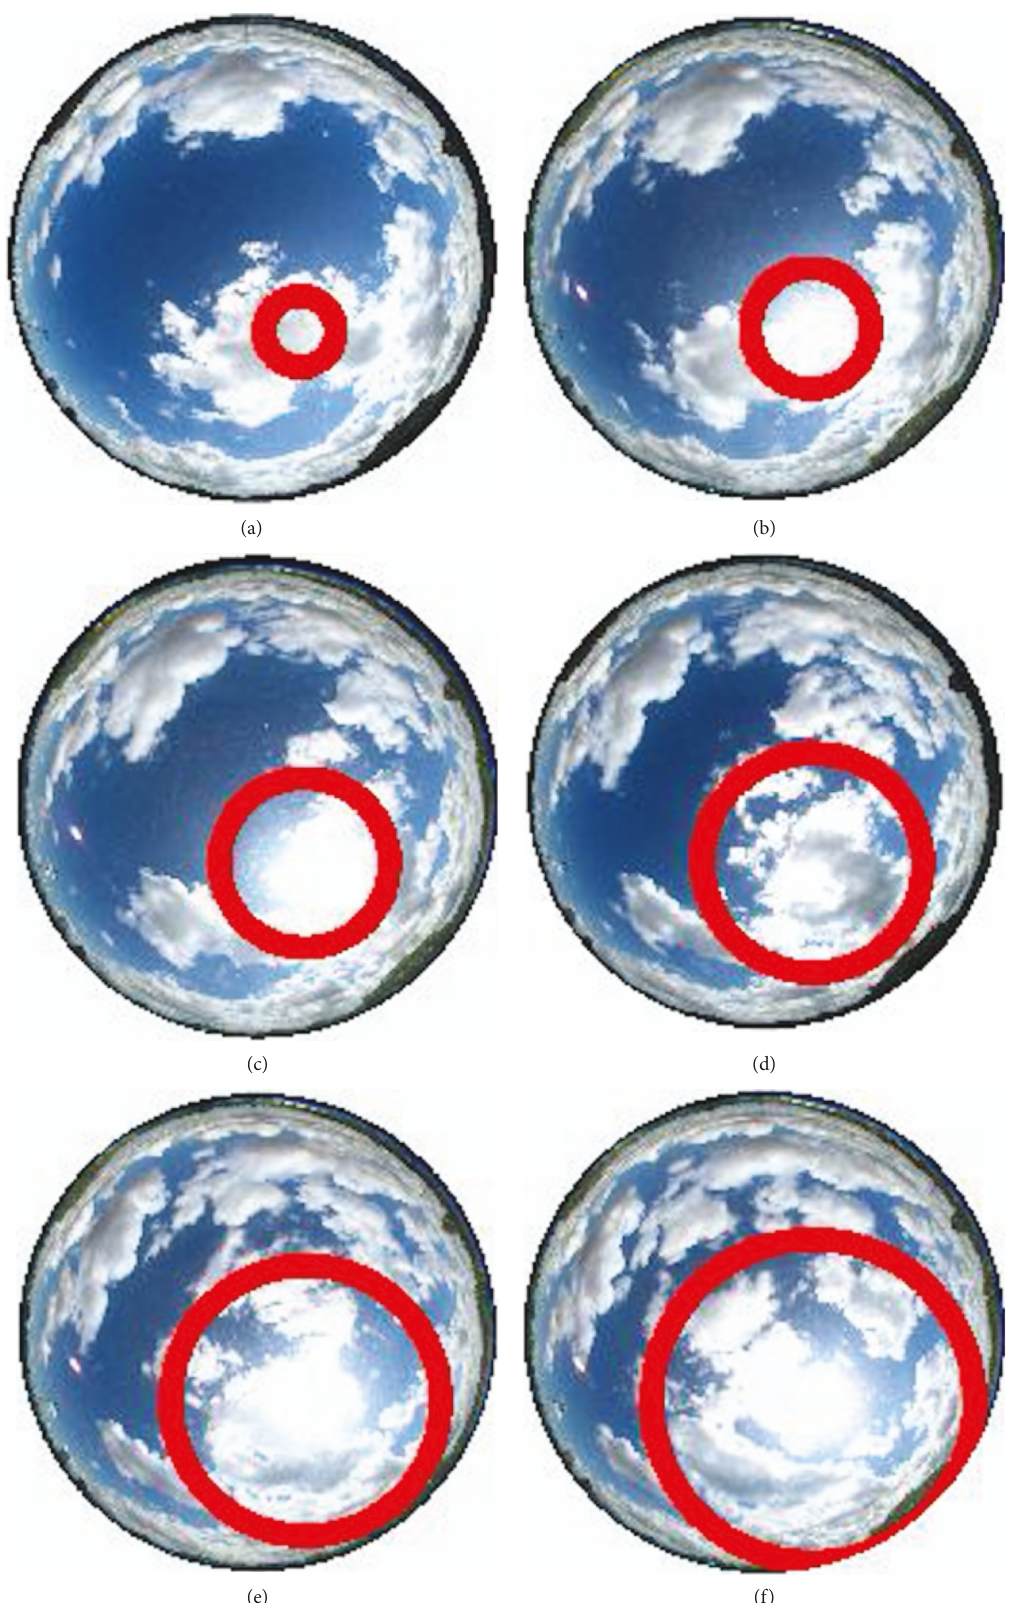
Figure 4: Observation of all-sky images on 22nd June 2014. The red circle in (a) corresponds at 12:51. (b) at 12:52. (c) at 12:53. (d) at 12:54. (e) at 12:55. (f) at